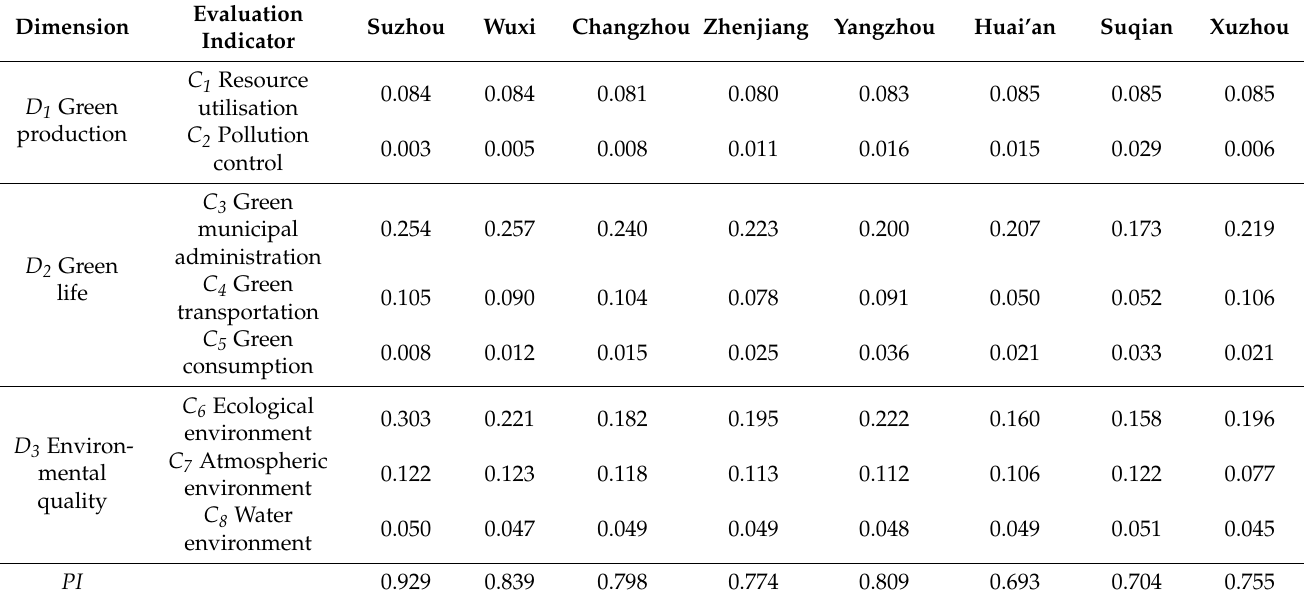
Table 13. Results of evaluation for 2009.